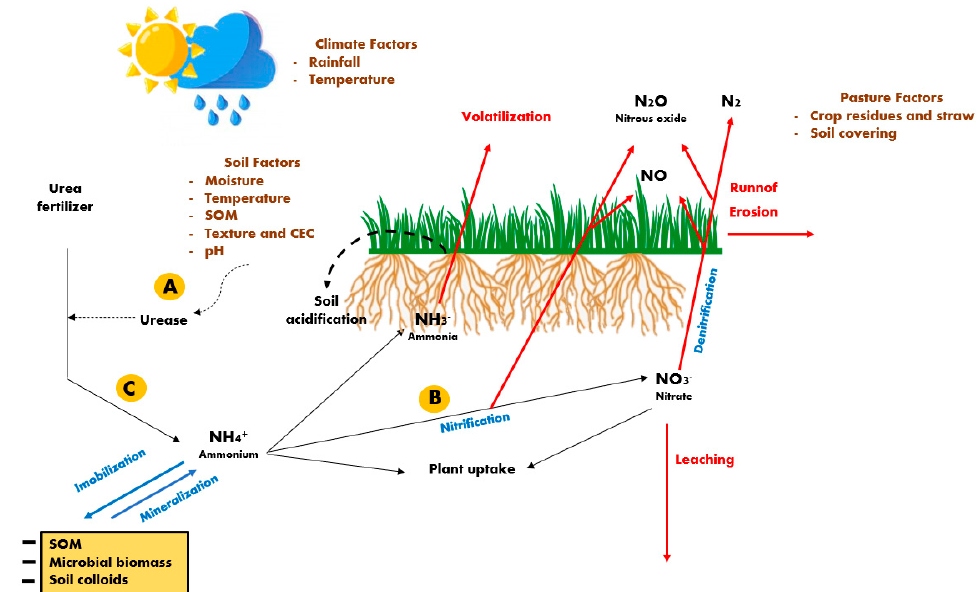
Figure 1. Simplified diagram showing the fate of N from urea fertilizers in tropical perennial grasses. Letters A, B and C represent the point of action of urease inhibitors, nitrification inhibitors, and polymer-coated urea fertilizer, respectively. Adapted from [28].